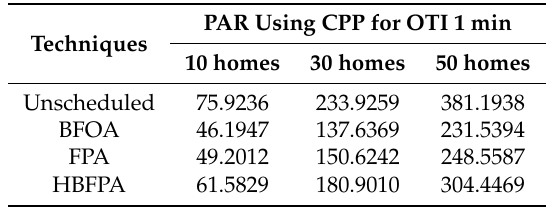
Table 14. Peak to average ratio for 24 h (for multiple homes).